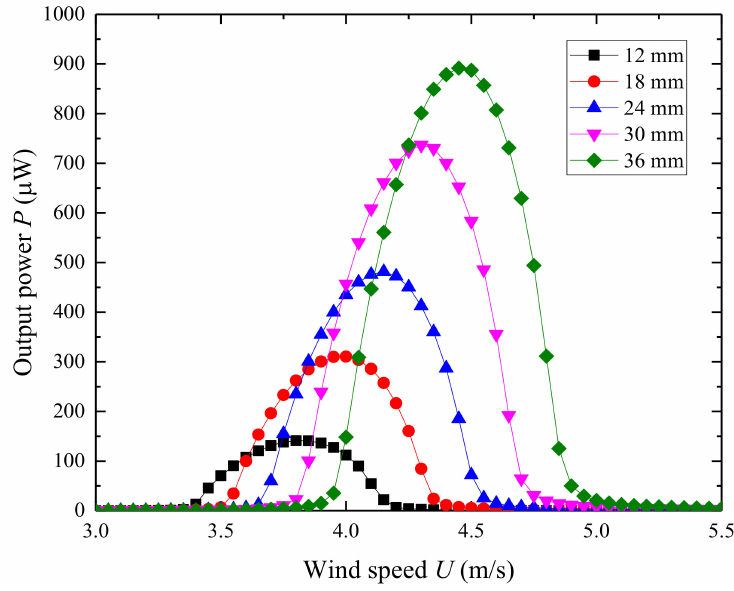
Figure 12. Variation of the output power P related to the length of piezoelectric